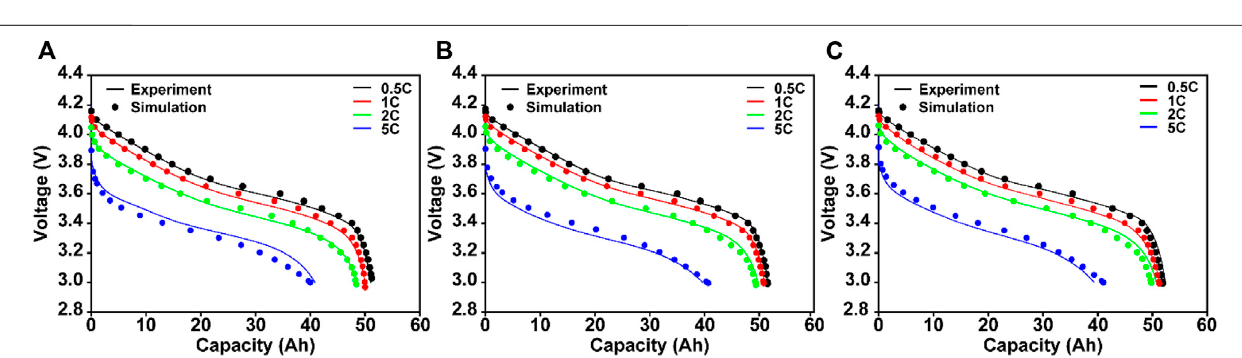
Figure 5 . Because the heat source caused by electrochemical reactions ( Supplementary Figure S5 ) and the heat transfer through convection were well simulated at various C-rates and exterior temperature conditions, the accuracy was high, similar to the simulated capacity values and voltage pro fi les. For instance, even at 5C (the most extreme case) the simulated temperatures of 25 ° C, 35 and 45 ° C showed high accuracy of 97.89% ( Figure 5A ), 97.05% ( Figure 5B ), and 98.44% ( Figure 5C ), respectively. Our cell model can also estimate the overall temperature distribution in the 3D cell structure, including the pouch package, as shown in Figure 5 (top). However, tab heating caused by internal resistance was excluded because information on the welding condition was not available.